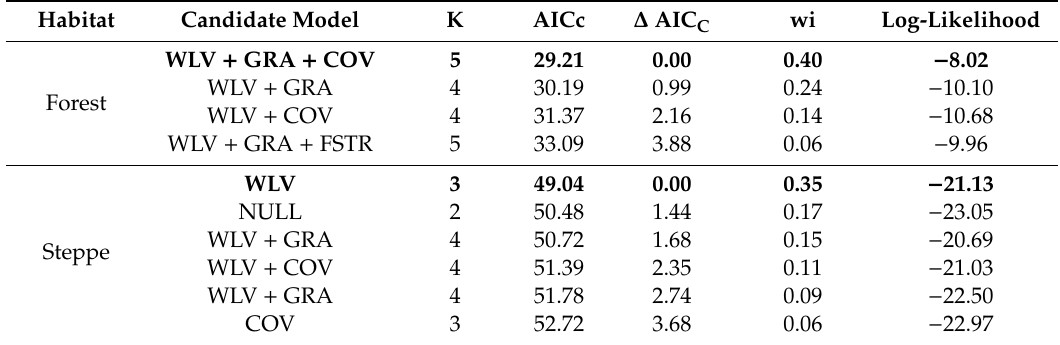
Figure 3. Probability of lodge abandonment and water level variation. Water level variation represents the increase or decrease in water level compared to the previous year’s level. Gray area denotes 95% confidence intervals. Points represent sampled lodges. Table 4. Ranking of candidate models to determine the probability of abandonment in within-habitat models.